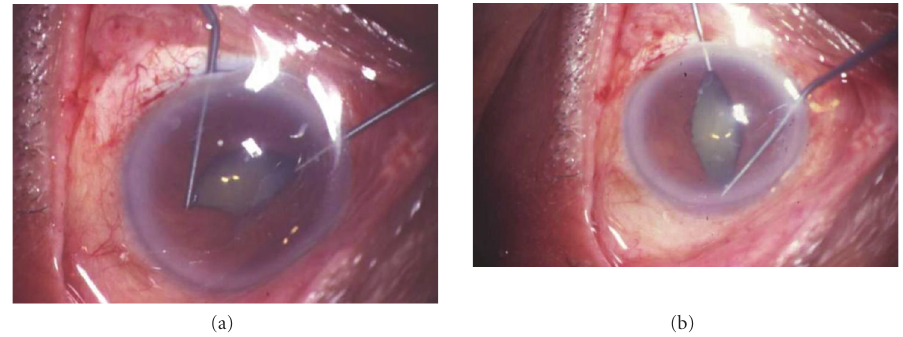
Figure 4: Intraoperative use of Kuglen hooks to stretch and dilate the pupils.